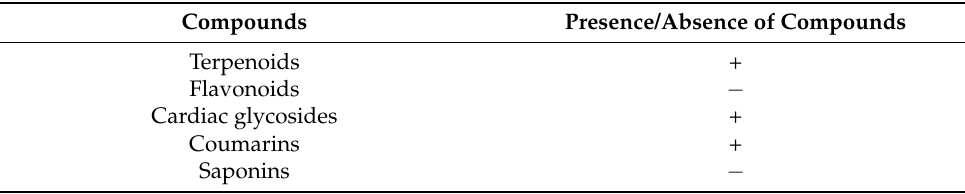
Table 3. The qualitative chemical components of the fungal extract. Compounds Presence/Absence of Compounds Terpenoids + Flavonoids − Cardiac glycosides + Coumarins